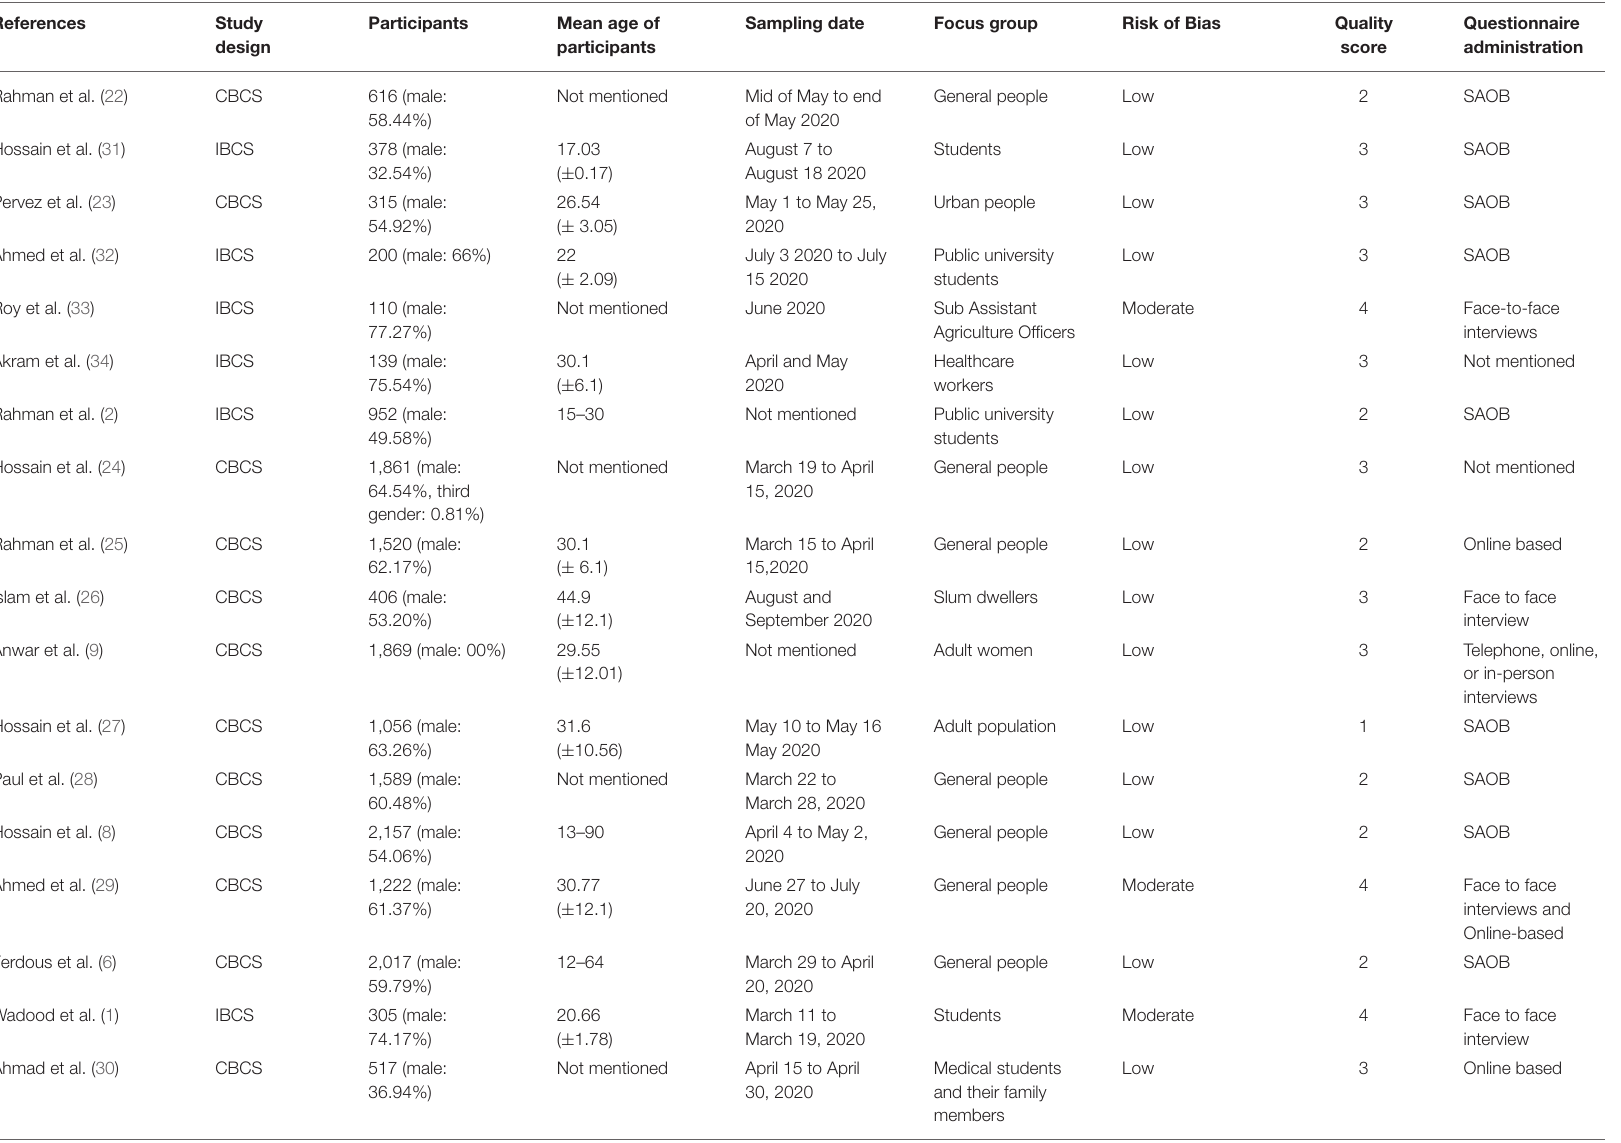
TABLE 1 | Demographic characteristics of the